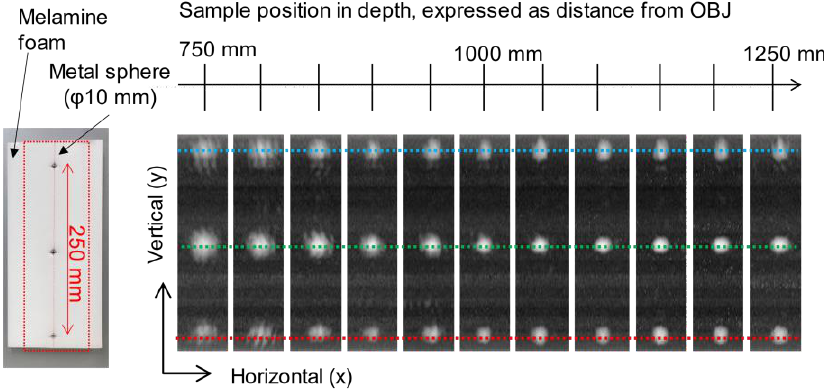
Figure 13. Reflected images of three metal spheres at different distances on the optical axis. The grayscale images in Figure 13 are images with different depth positions of the target. The three white circles aligned vertically are metal spheres, and the spacing